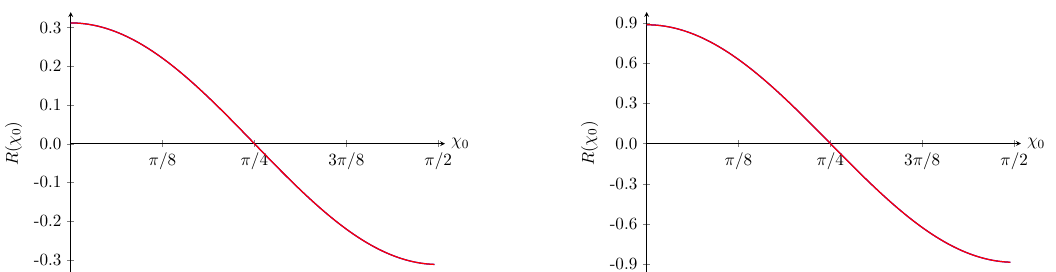
Figure 1 . Normalized surface-subtracted Stokes parameter R as a function of (cid:31) 0 . The blue lines correspond to R ( (cid:31) 0 ) obtained from averaging over (cid:1) (cid:30) 0 as dictated in (3.3) while the red lines correspond to P a ! (cid:13) cos(2 (cid:31) 0 ) following (3.9). The ALP and magnetar parameters are ! = 1 keV, m a = 10 (cid:0) 9 keV, g = 10 (cid:0) 15 keV (cid:0) 1 , r 0 = 9 km, B 0 = 10 14 G and (cid:18) = (cid:25)= 4 for the left panel while they are ! = 10 keV, m a = 10 (cid:0) 8 keV, g = 10 (cid:0) 14 keV (cid:0) 1 , r 0 = 11 km, B 0 = 10 13 G and (cid:18) = the right